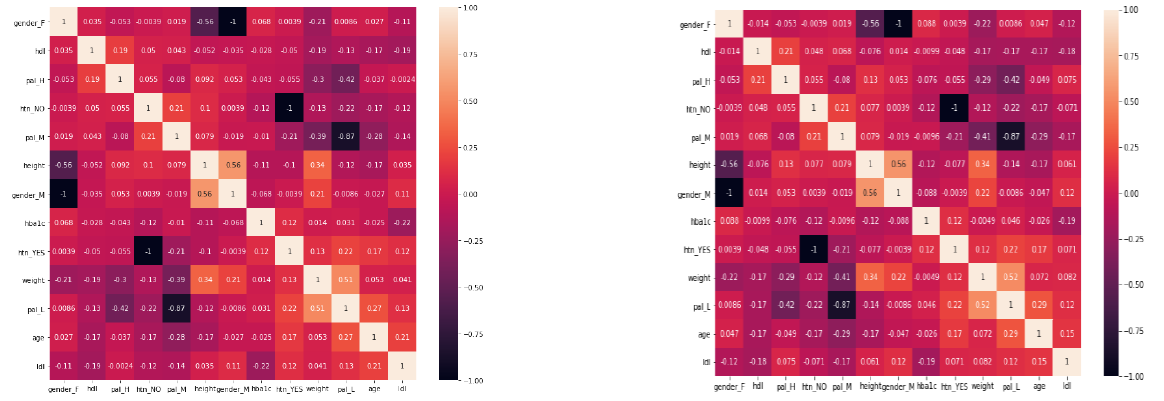
Figure 3. Comparison of correlation before and after hierarchical clustering based on Spearman’s ranking. These insights give us some hints into the diabetic disease, its development, and asso- ciated complications.